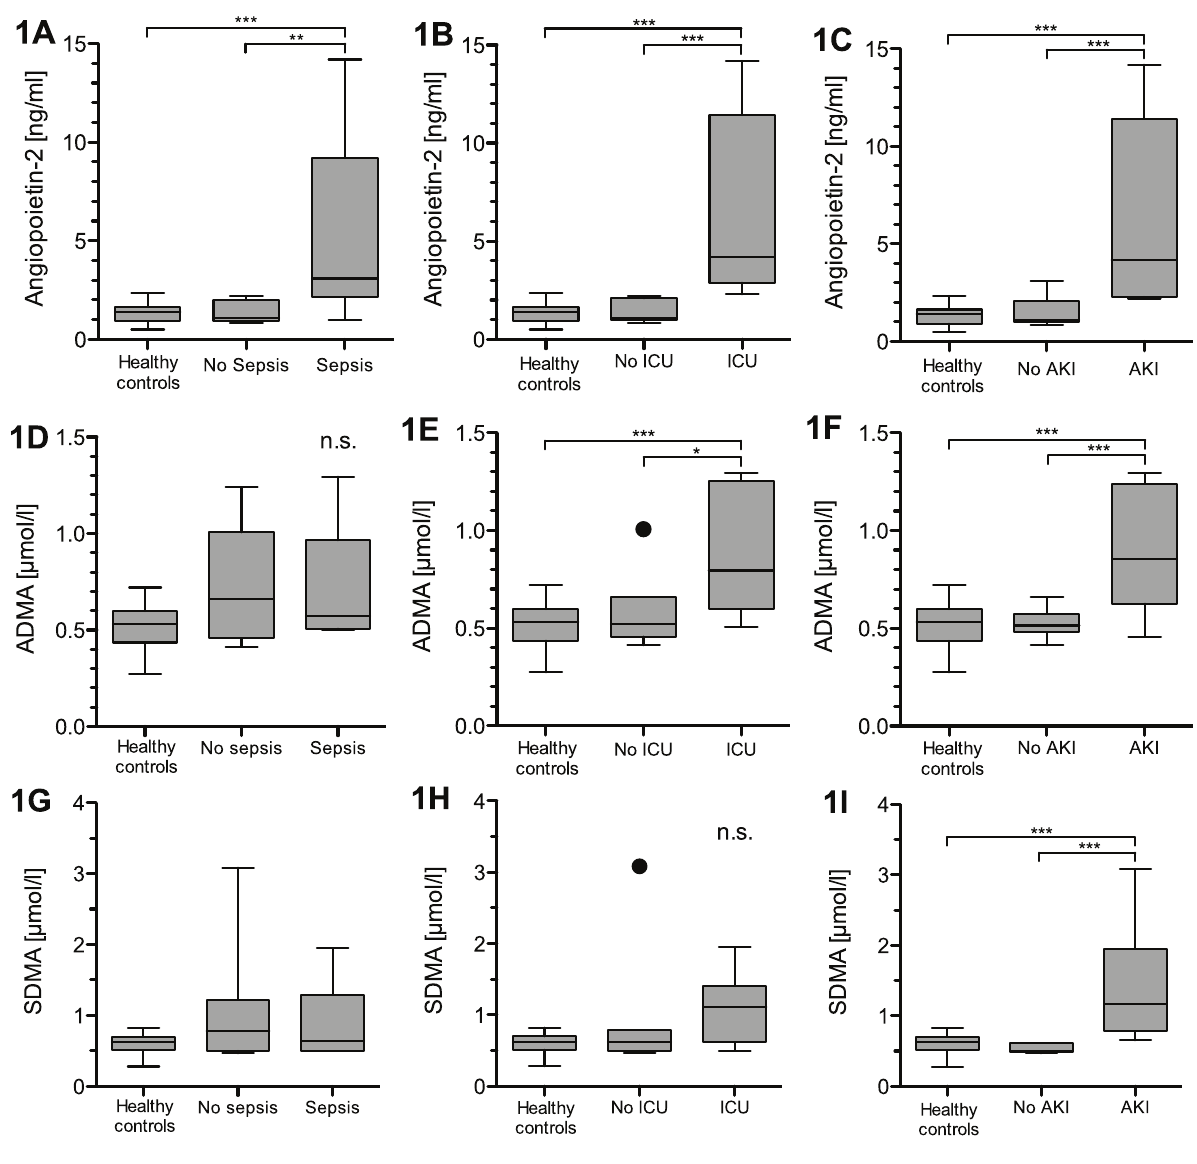
Figure 1. Box plots of results in healthy controls and study patients. Circulating Angpt-2 in septic patients (n=8) (A), patients with need of intensive care treatment (n=6) (B) and patients developing AKI (n=7) (C). Circulating ADMA in septic patients (D), patients with need of intensive care treatment (E) and patients developing AKI (F). Circulating SDMA in septic patients (G), patients with need of intensive care treatment (H) and patients developing AKI (I). (n.s.=not significant, *=p , 0.05, **=p , 0.001, ***=p ,